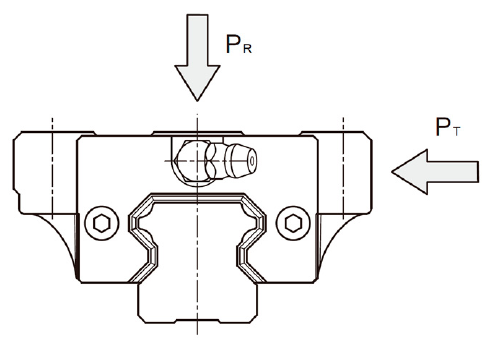
Figure 3. Linear guide load direction [32].